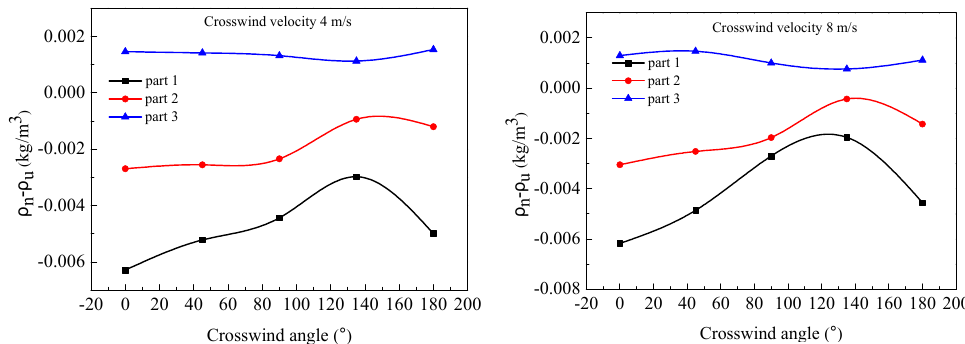
Figure 8. Air density difference at the eliminator top with different fill layout patterns. Figures 9 and 10 show the streamlines at the plane of xz and z = 4 m with the crosswind velocity of 8 m/s. When the crosswind angle is 0 ◦ , the air velocity gradually decreases from the air inlet to the inner zone of the tower. There are two vortexes derived from low-pressure areas in the leeward side of the tower. Under the crosswind angle of 45°, there are three vortexes around the tower. One of them occurs inside the tower and the others are outside the tower. The volume of the vortex inside the tower is larger, leading to increased airflow resistance and reduced ven- tilation volume of the tower.